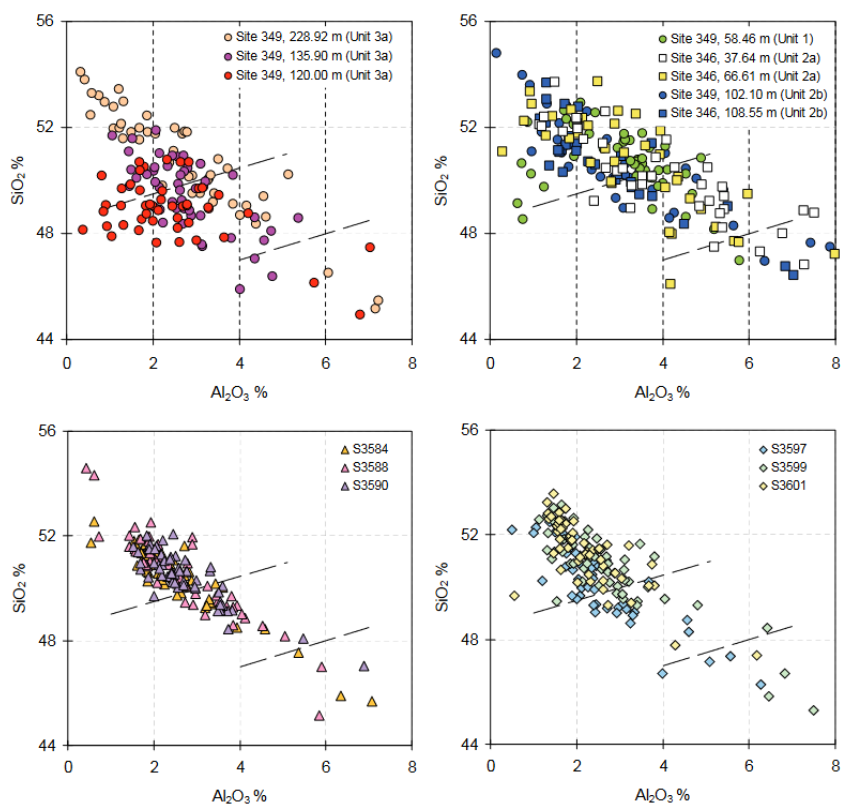
Figure 10. Clinopyroxenes from Deep Sea Drilling Project sites and Kap Brewster plotted on SiO 2 ‐ Al 2 O 3 diagrams of LeBas [41]. Kap Brewster samples S3584, S3588 and S3590 are from the Boplads ‐